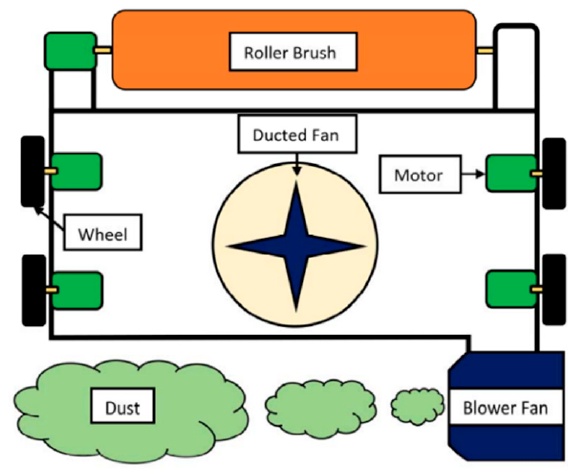
Figure 6. Schematic of cleaning robot [23].